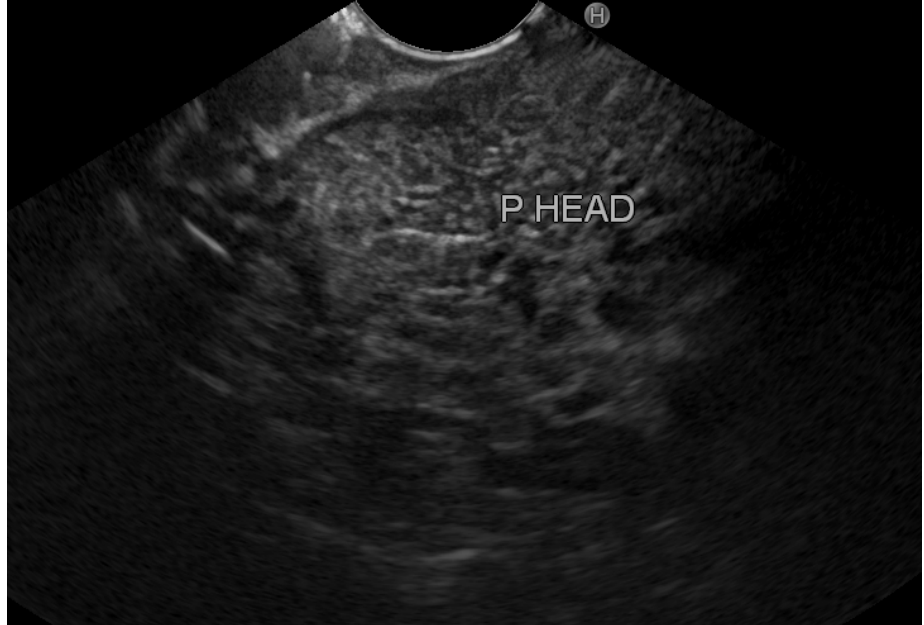
Figure 2. Inflamed pancreatic parenchyma. P HEAD: pancreatic head.